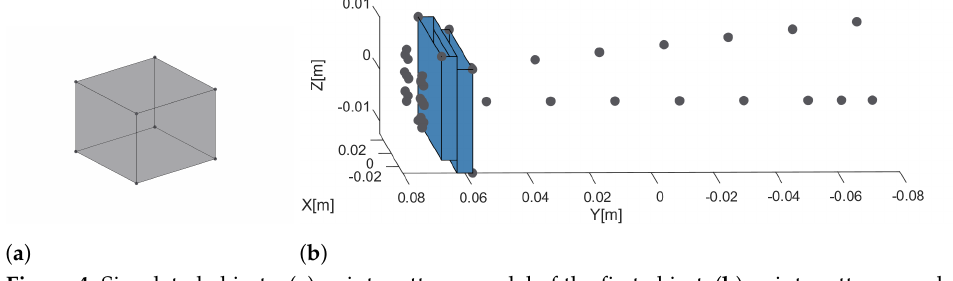
Figure 4. Simulated objects. ( a ) point scatterer model of the first object; ( b ) point scatterer model of the second